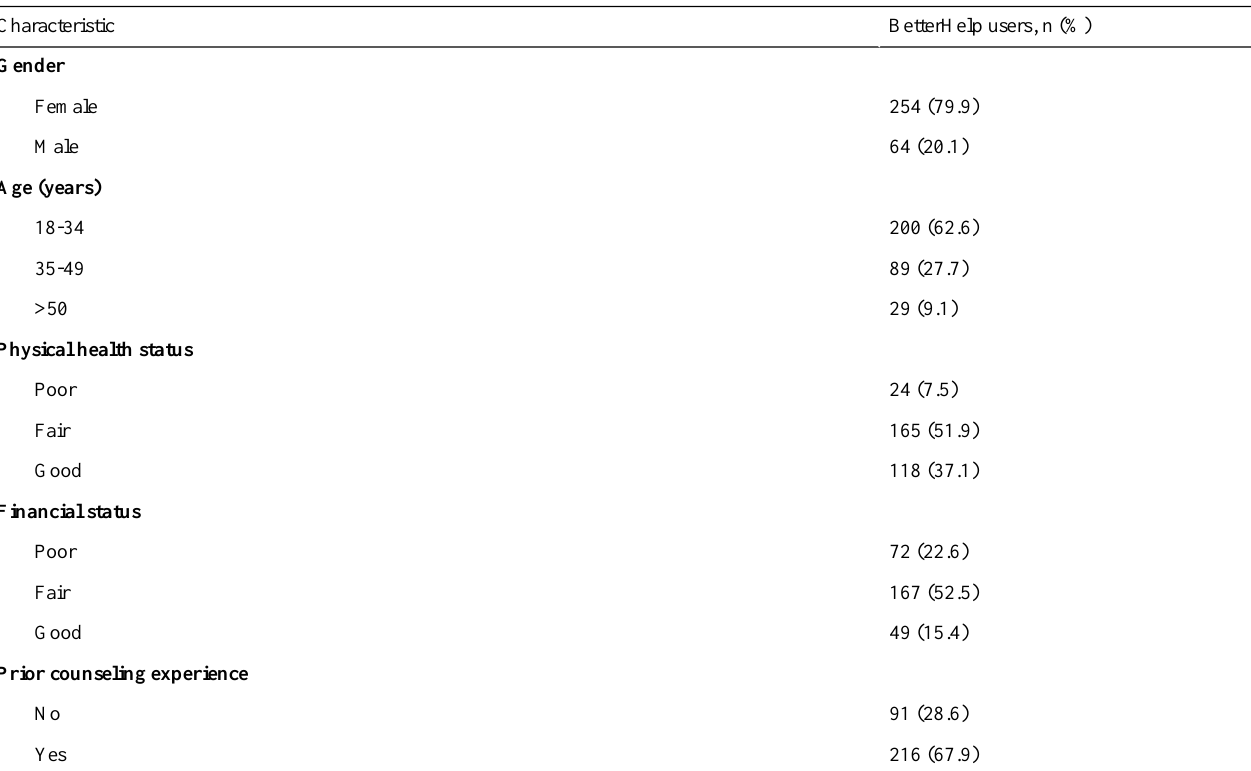
Table 2. Sociodemographic characteristics of BetterHelp